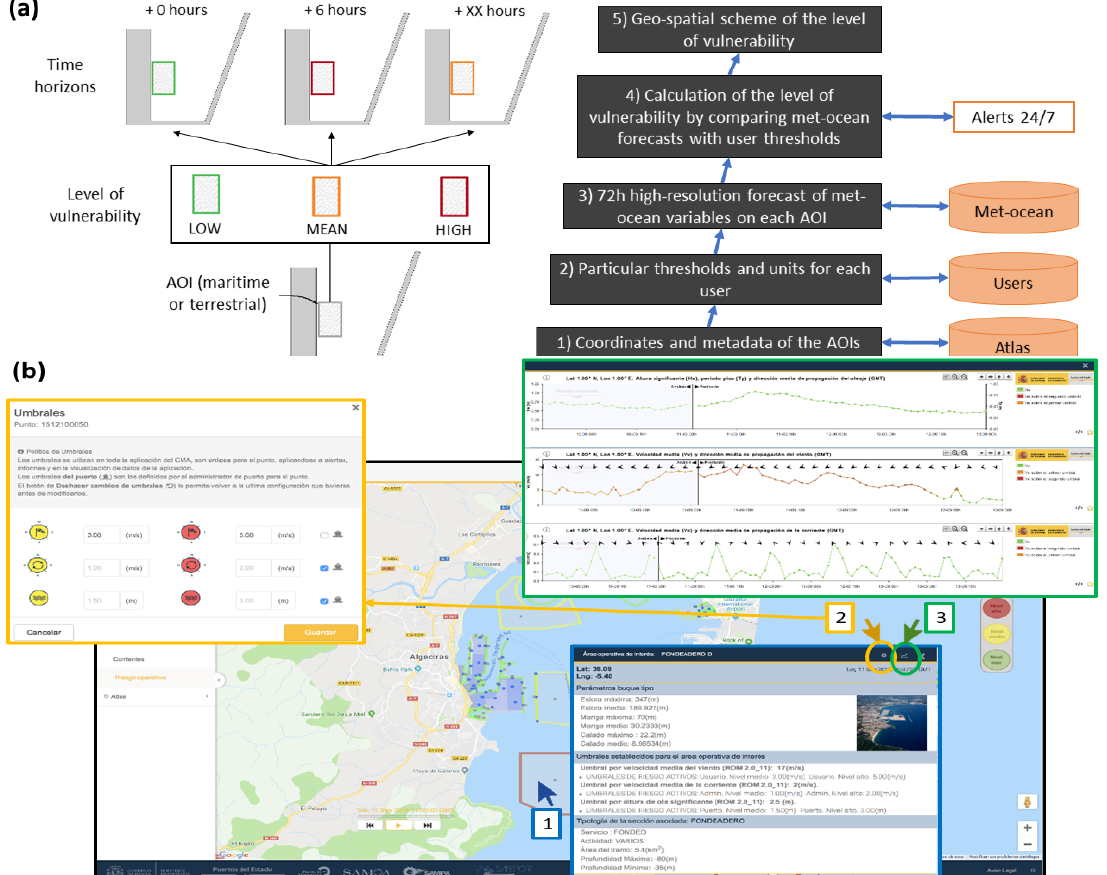
Figure 10. ( a ) Conceptual scheme for the development of the Atlas of Operational Vulnerability (AOV) of the Meteorological and Oceanographic Support Systems for the Port Authorities (SAMOA 2 project);.( b ) AOV for the Port Authority of Algeciras (Spain), in which the vulnerability of each Area of Operational Interest (AOI) is represented by a traffic light color code together with a forecast time line up to 72 h. (1) By selecting an AOI, a pop-up is displayed with its metadata (identifier, typology, activity, quantitative aspects and characteristics of the fleet), an image and information about the default or user-customized thresholds. (2) By selecting the corresponding icon within pop-up 1, a new pop-up is displayed allowing the user to customize the thresholds and units associated with that AOI. (3) By selecting the corresponding icon within pop-up 1, 72 h forecast time series of main met-ocean variables at the AOI are offered (wind, wave agitation and currents), in which the units and color code are particularized for each user. Own elaboration from CMA (https://cma.puertos.es/). Apart from this tool, the users from CMA were offered the possibility of defining alerts inside different ports, based on overcoming met-ocean forecasts such as wind velocity and wave agitation. In this case, these variables are not always linked to high-resolution models. Each port establishes default thresholds for the met-ocean variables based on PIANC (2012) [19] and ROM 2.0 (2011) [18]. However, as a similarity with the AOV, users can also customize their own thresholds. After surveying and filtering the information from CMA, so far, a total of 79 users from 17 Spanish State Ports have been counted to customize their own thresholds. Algeciras and Barcelona were the ports with more customizing users, with a number of 27 and 15 users, respectively. Every user is allowed to customize their met-ocean thresholds in different POIs (Point of Operational Interest, which are either the centroid of an AOI or any other points of relevance, regarding operability, in which met-ocean forecasting is provided), either maritime or terrestrial, inside the port area. As a result, 94 POIs were customized with wave agitation thresholds and 139 POIs with wind velocity thresholds. This information, summarized in Figure 11a, highlights that not every user